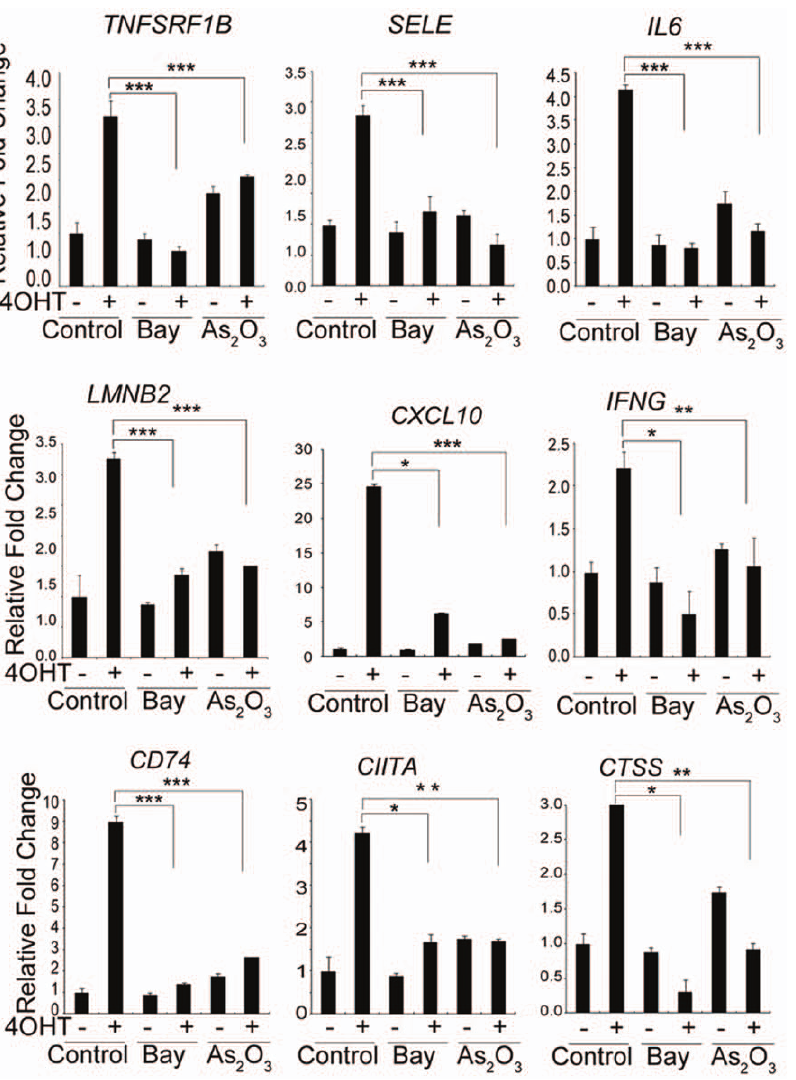
Figure 3. NF- k B inhibitors block K13-regulated genes. BCBL1 K13-ER TAM cells were treated with two NF– k B inhibitors (2 m M Bay 11-7082 or 2 m M As2O3) for 2 hours followed by 4OHT treatment for additional 24 hours and total RNA was isolated as described in the Materials and Method section. Nine genes were randomly picked and their relative mRNA levels were examined using real-time RT-PCR as explained in Figure 2A.